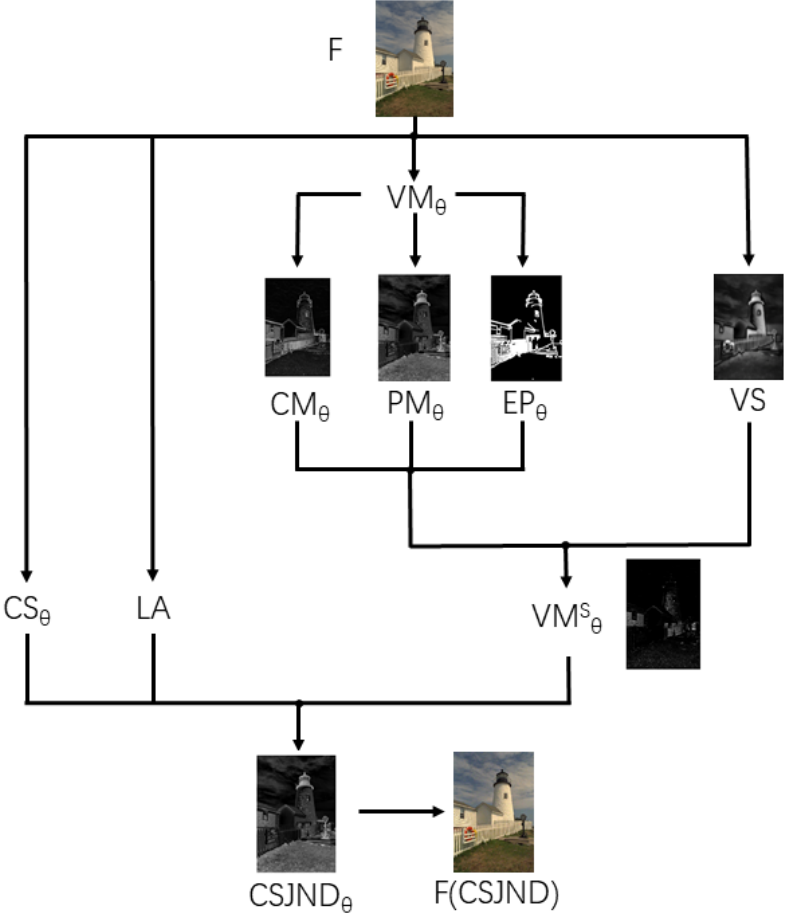
Figure 1. The framework of the proposed CSJND